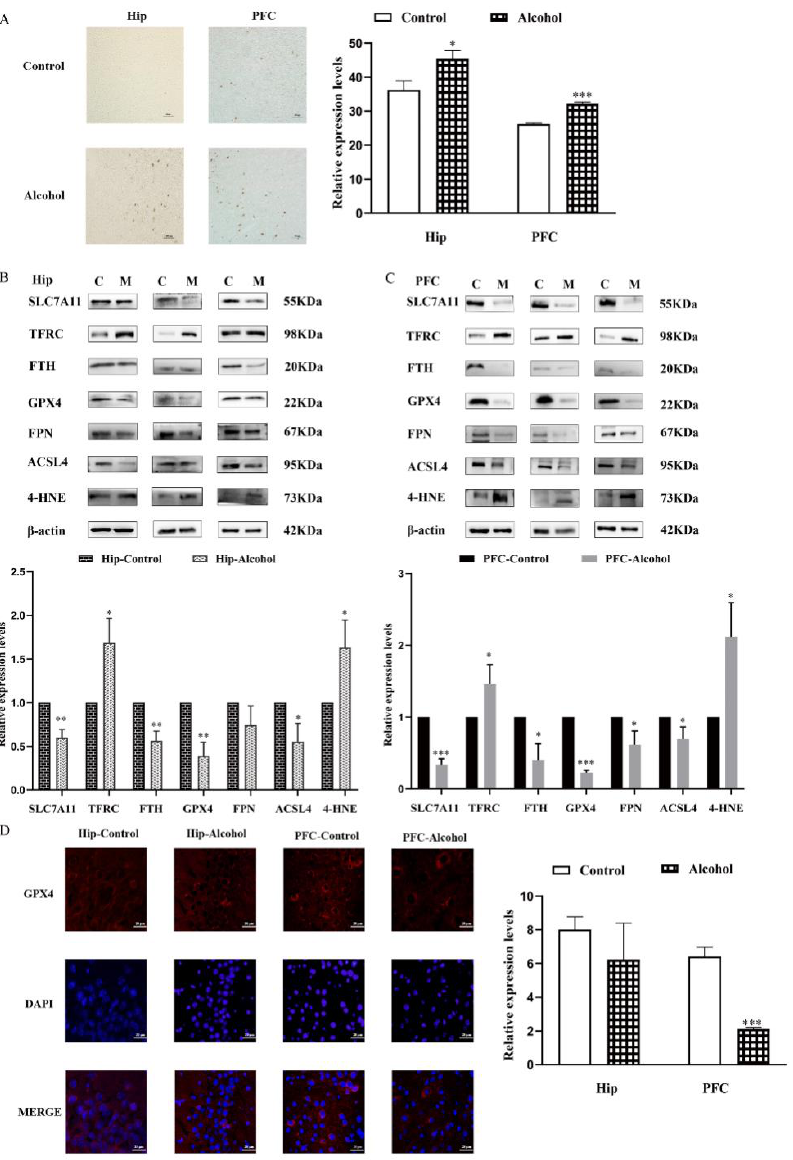
Figure 4. The ferroptosis pathway was involved in alcohol-induced mental disorder. ( A ) Iron staining of hippocampus (Hip) and prefrontal cortex (PFC) (magnification: 400 × ), ( B ) western blot